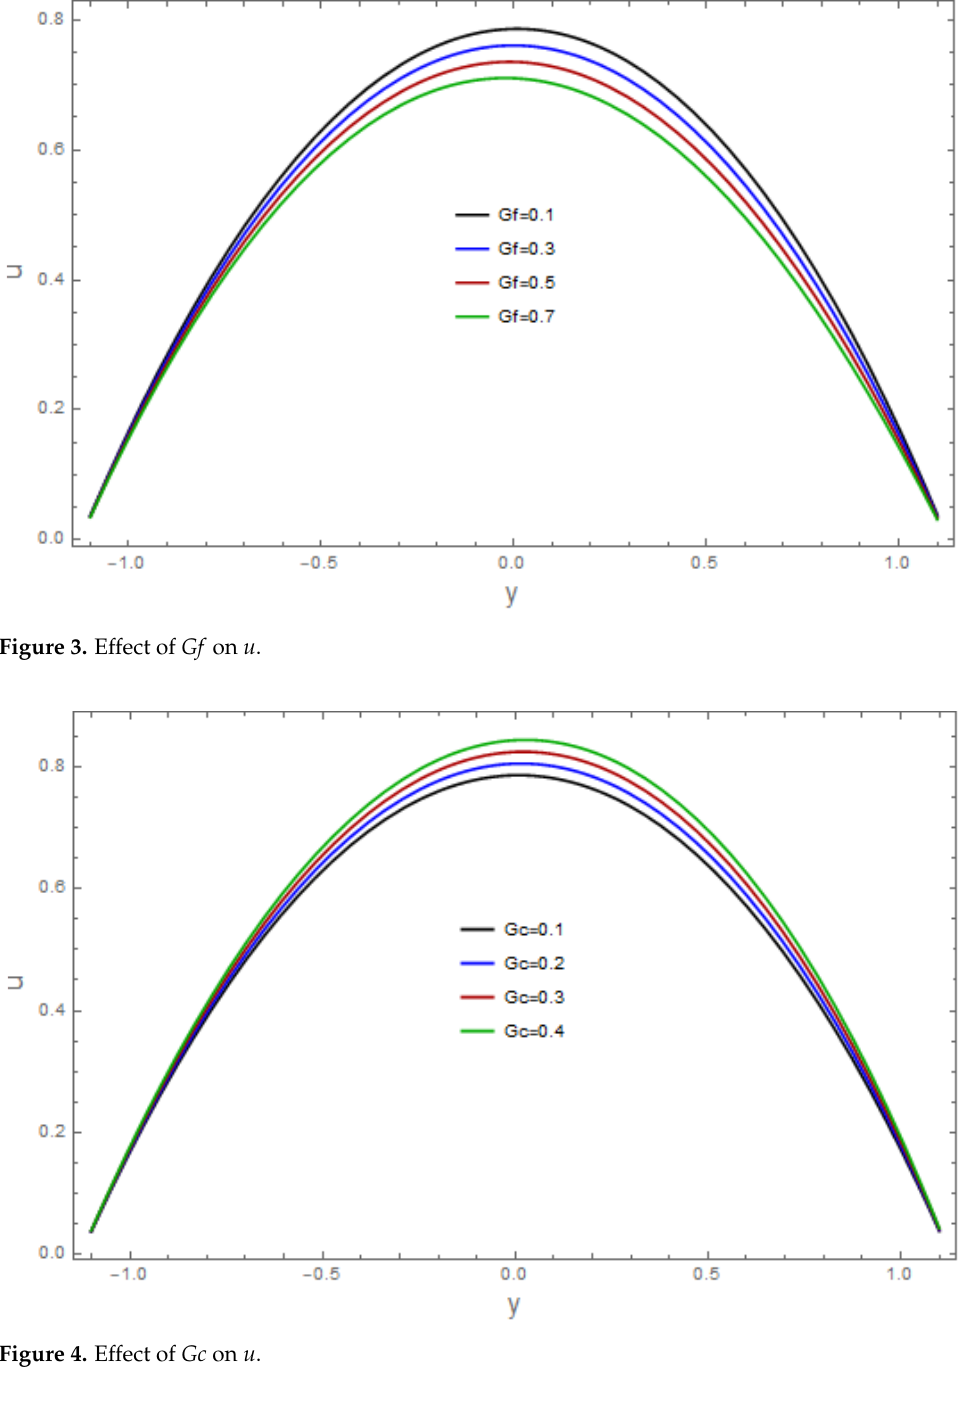
Figure 4. Effect of 𝐺𝑐 on 𝑢 .